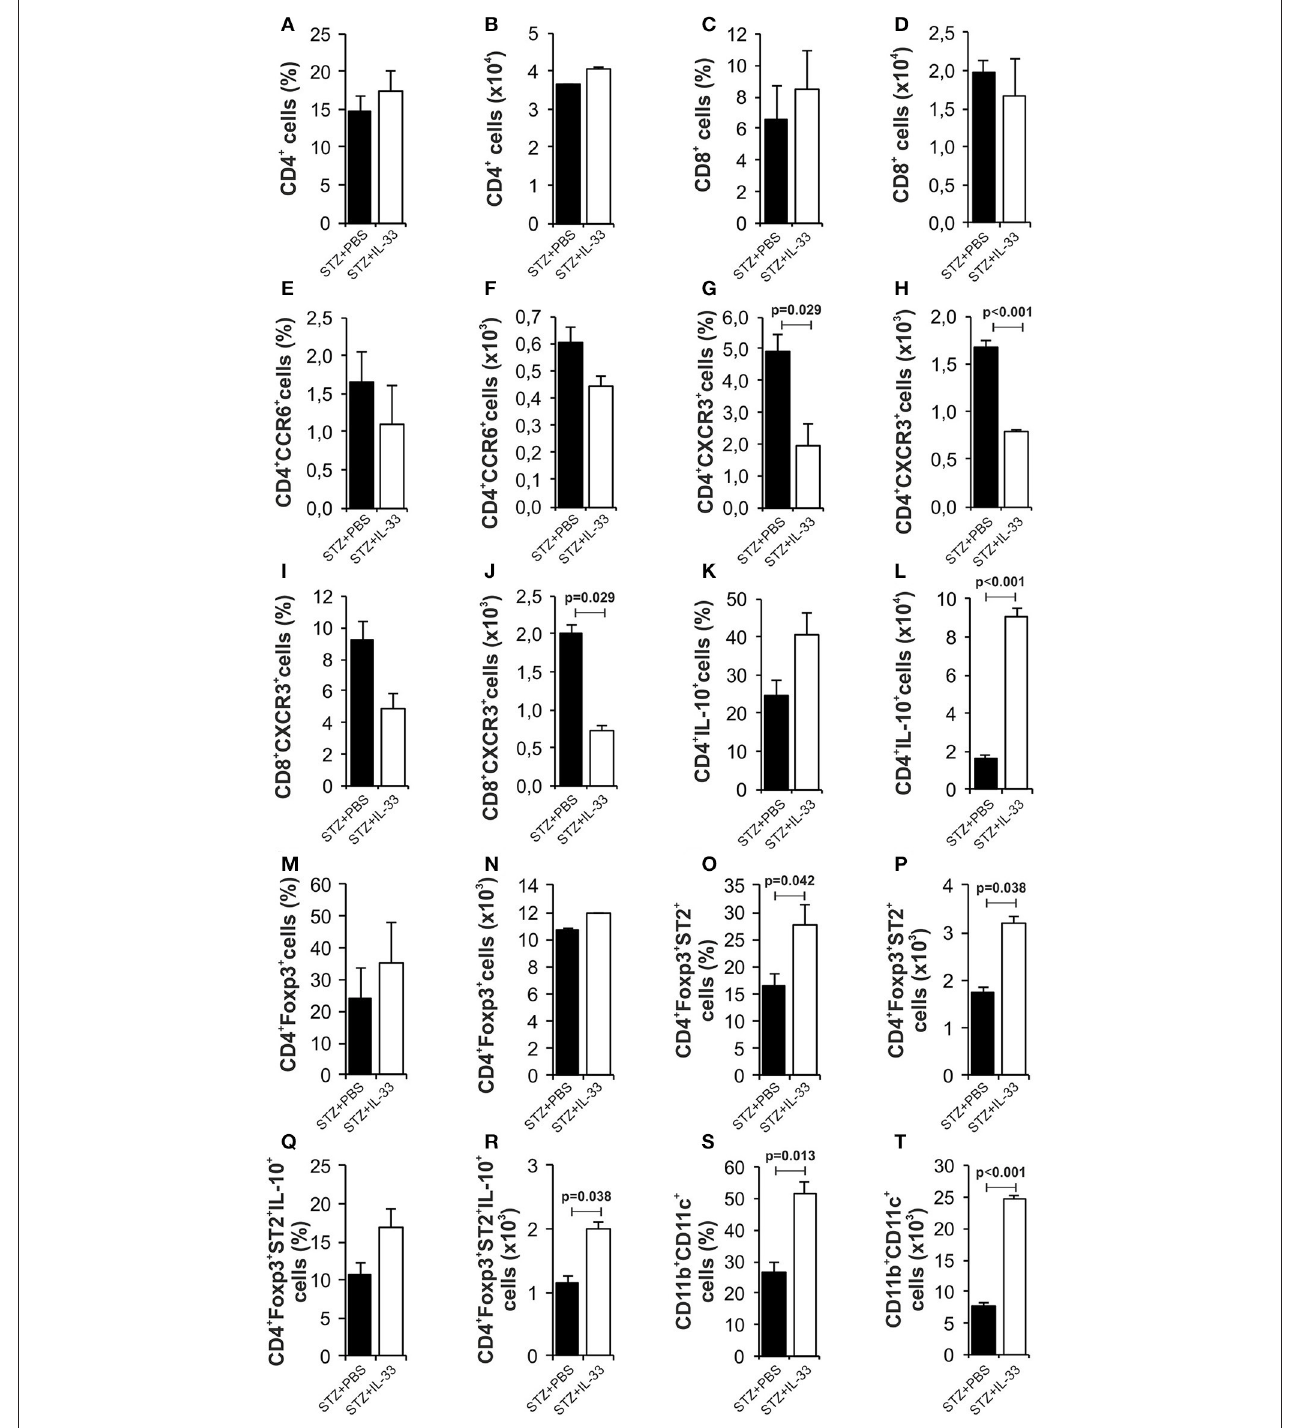
FIGURE 4 | IL-33 attenuates influx of inflammatory cells and promotes regulatory cells infiltration in the pancreatic islets. The percentage and total number of CD4 + (A,B), CD4 + CCR6 + (C,D), CD4 + CXCR3 + (E,F), CD4 + IL-10 + (G,H), CD8 + (I,J) , CD8 + CXCR3 + (K,L) , CD4 + Foxp3 + (M,N) , CD4 + Foxp3 + ST2 + (O,P) , CD4 + Foxp3 + ST2 + IL-10 + (Q,R), CD11b + CD11c + (S,T) were examined. IL-33 treatment significant decreases effector CD4 + CXCR3 + and CD8 + CXCR3 + cells and increases percentage of regulatory cells, myeloid dendritic cells. The animals were treated with 0.4 µ g/injection IL-33 together with MLD-STZ (i.p. 40 mg/kg for 5 consecutive days) or of an equimolar dose of PBS or with 0.4 µ g/injection IL-33 together with citrate buffer. Cells were obtained from pancreatic islets on day 28 after diabetes induction. Data from two individual experiments with at least 8 mice per group are shown as mean ± SEM; by paired t -test when compared with values obtained with phosphate-buffered saline.